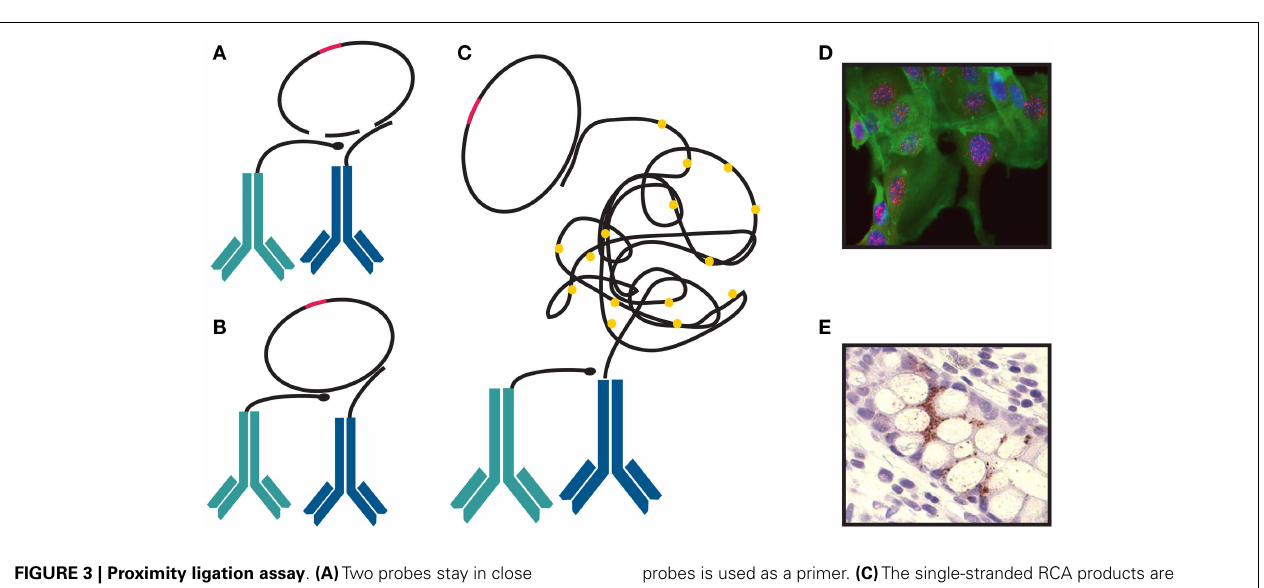
FIGURE 3 | Proximity ligation assay . (A) Two probes stay in close proximity by binding to a protein or two proteins present in one complex. (B) They are joined and circularized by DNA ligation upon introduction of linear connector oligonucleotides. After ligation, rolling-circle amplification (RCA) is initiated. One of the proximity